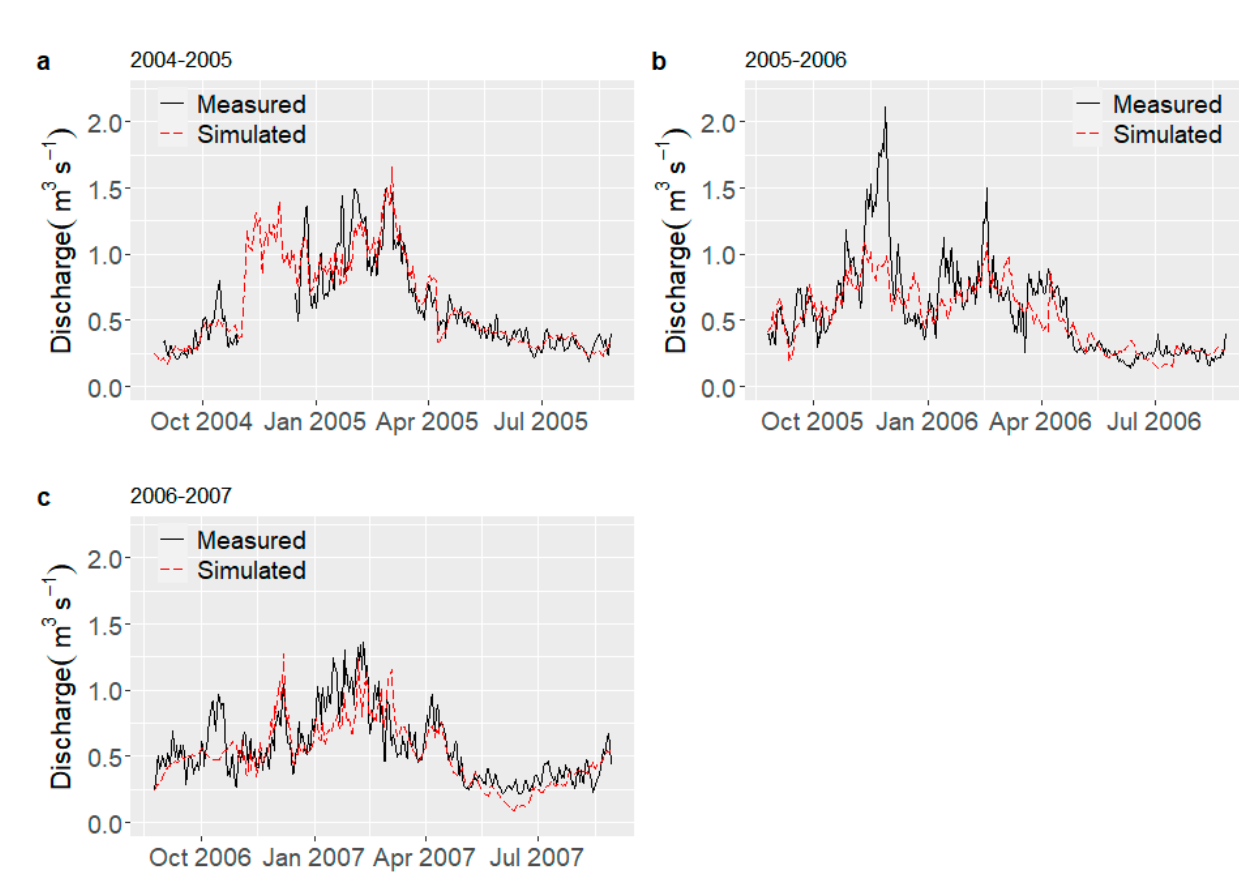
Figure 3. Simulated and measured yearly ( a ) (2004–2005), ( b ) (2005–2006), ( c ) (2006–2007) discharge at the outlet of Artesoncocha lake.